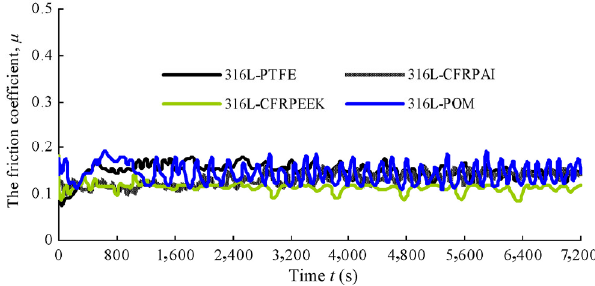
Fig. 2 Variation of the friction coefficient of 316L against PTFE, CFRPAI, CFRPEEK, and POM.